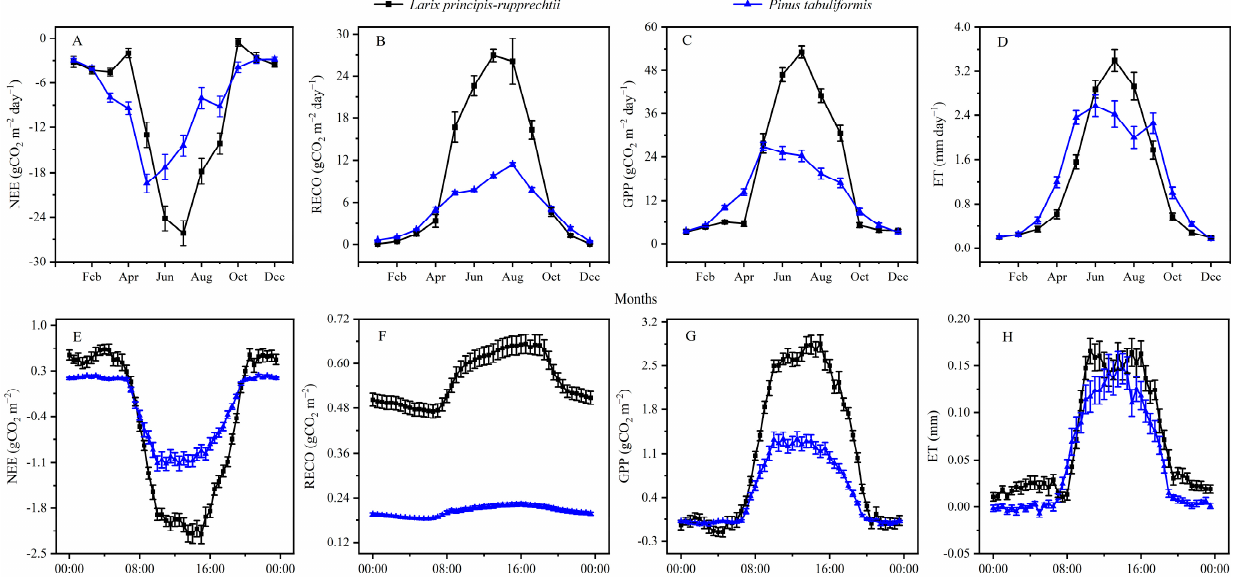
Figure 3. Monthly variations ( A – D ) of CO 2 and H 2 O fluxes (net ecosystem exchange (NEE), ecosys- tem respiration (RECO), gross primary production (GPP), evapotranspiration (ET)), and hourly variations ( E – H ) of CO 2 and H 2 O fluxes (NEE, RECO, GPP, and ET) in two forest ecosystems. The value for each point in each panel represents the mean value and standard error during the whole analysis period.